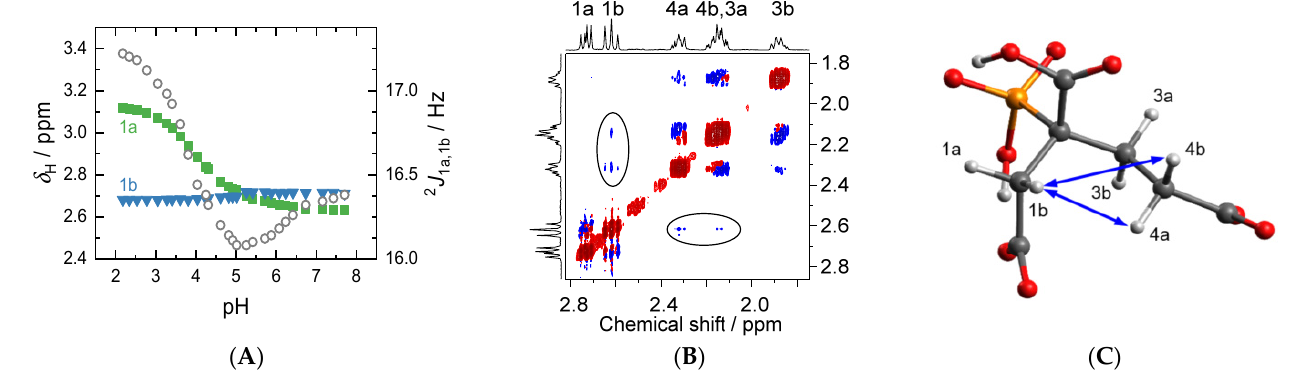
Figure 6. ( A ) 1 H chemical shift (left y -axis) of H1a and H1b (green squares and blue triangles, respectively) as well as their geminal coupling constant (right y -axis, absolute values, open circles) in dependence on pH, as determined from 1 H{ 31 P} NMR spectra shown in Figure 1B. ( B ) NOESY spectrum (500 ms mixing time) of PBTC pH 4.4 solution, and ( C ) DFT-calculated structure of H 3 L 2 − , indicating the non-trivial NOE contacts by ellipses and arrows, respectively.